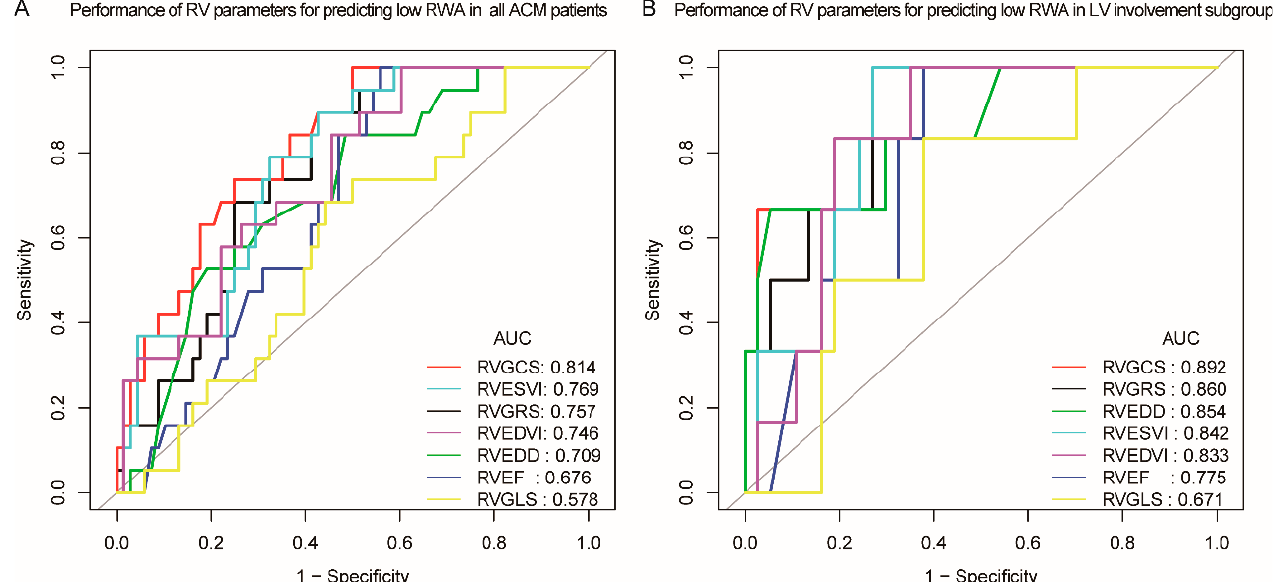
Figure 3. Receiver operating curves of RV parameters and low RWA. ( A ) Receiver operating curves showing the predictive performance of RV parameters in identifying patients with low RWA after ICD implantation in all ACM patients. ( B ) Receiver operating curves showing the predictive performance of RV parameters in identifying patients with low RWA after ICD implantation in ACM patients with LV involvement.